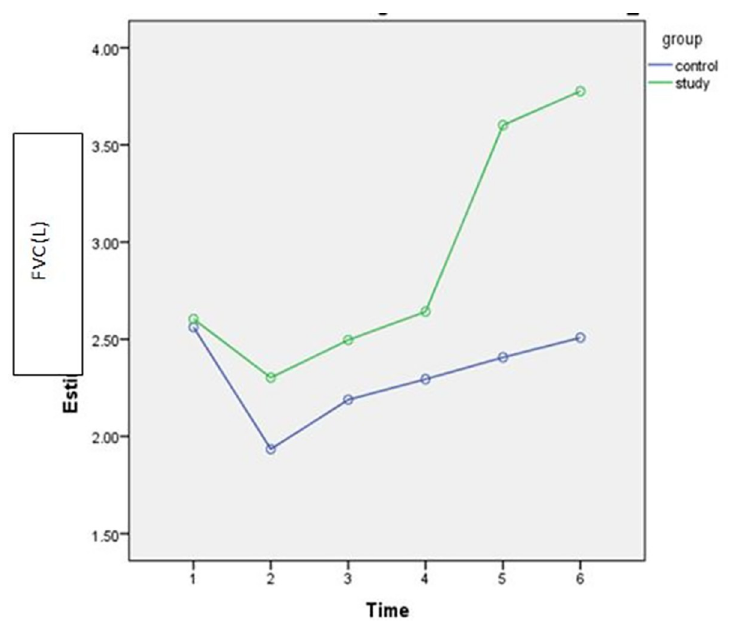
Fig 2. Estimated marginal means of FVC [1: Pre-operative; 2: POD3; 3: Discharge; 4: 4 th POW; 5: 8 th POW; 6: Follow-up]. https://doi.org/10.1371/journal.pone.0256609.g002 before intervention at the baseline (pre-operative) assessment (P > 0.05). However, statistically significant differences were found between groups after intervention (P < 0.05). The experi- mental group showed significant improvement in the distance measured by 6MWT over time (P < 0.001). By the end of intervention protocol (8 months), the functional capacity in the